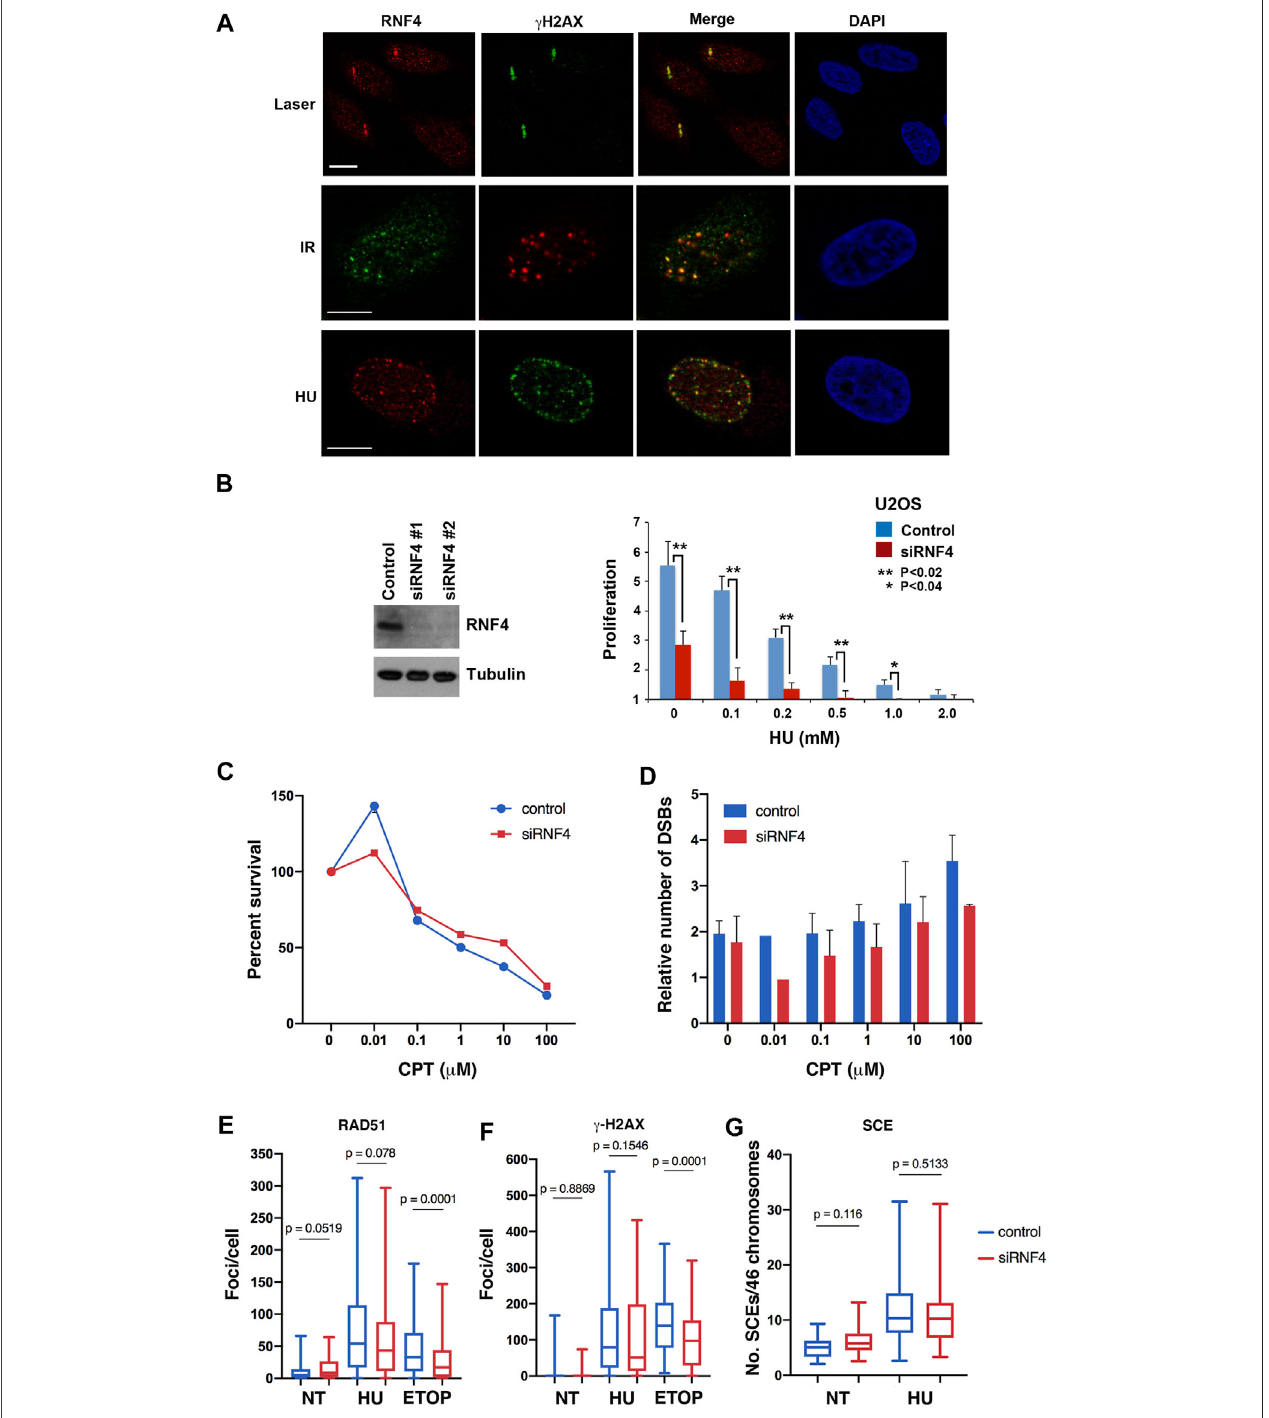
FIGURE1| RNF4wasnotrequiredforHRrepairofreplication-associatedDSBs. (A) RNF4co-localizedwithphosphorylatedhistoneH2AX( c -H2AX)inU2OScells treated with a micro-laser, ionizing radiation (IR), or hydroxyurea (HU). DNA was detected with DAPI. Bars (cid:1) 10 µm. (B) RNF4 depletion in U2OS cells by two unique RNF4-speci fi csiRNAs wasevaluatedbyimmunoblot analysis.Proliferation defect inRNF4-depleted U2OScellsexposedtovaryingconcentrationsofHUfor72 h. Error barsrepresentstandarddeviationsfromthreebiologicalreplicates. p valuesweredeterminedusingaStudent ’ s t -test. (C) Linegraphshowingresultsofclonogenic survival assays on RNF4-depleted and control-depleted HeLa cells exposed to varying concentrations of camptothecin (CPT) for 3 h. Results from three independent assayswereaveragedandstandarddeviationsshown. (D) BargraphsshowingtherelativelevelsofDSBsinRNF4-depletedandcontrol-depletedHeLacellsexposedto